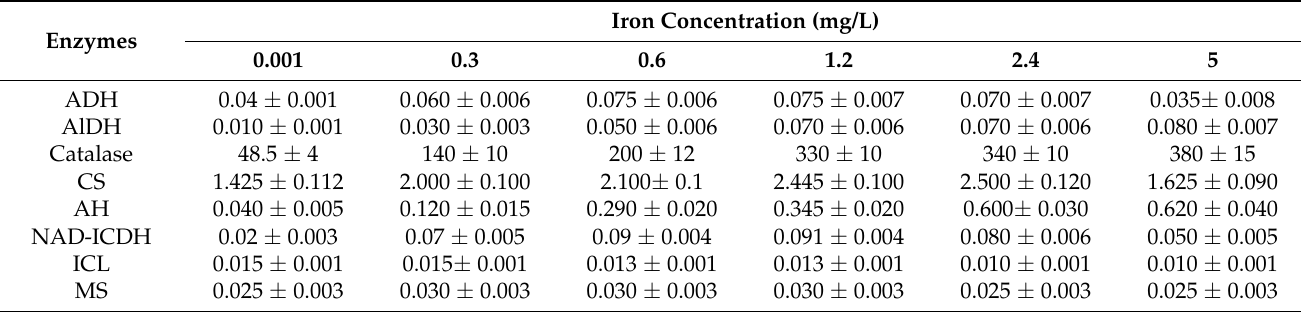
Table 4. Effect of iron concentration on the enzyme activities (U/mg protein) of Y. lipolytica VKM